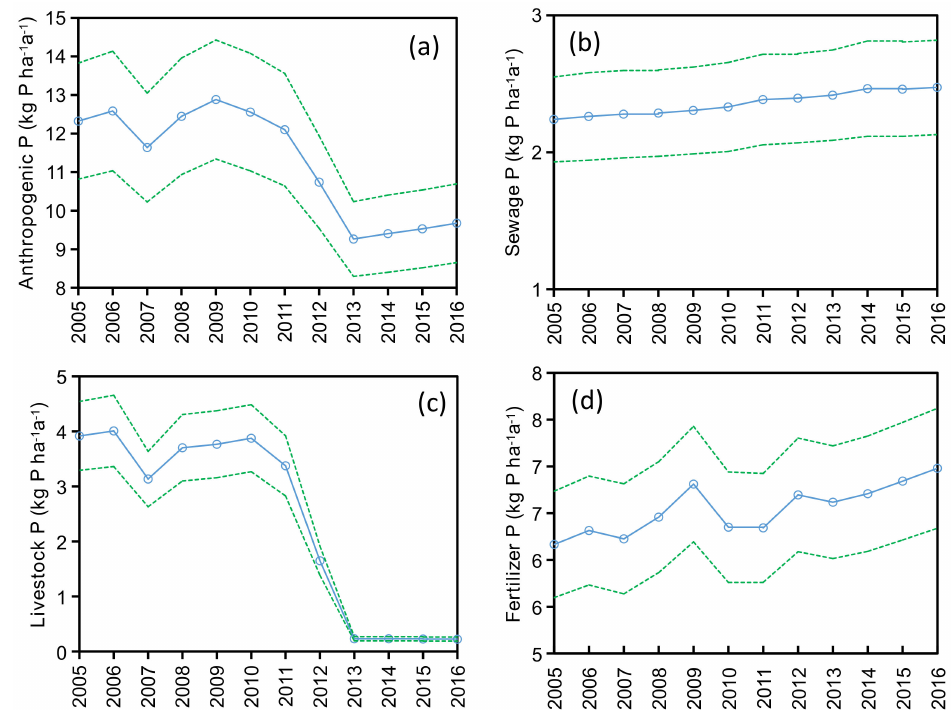
Figure 5. Annual ( a ) anthropogenic P, ( b ) sewage P, ( c ) livestock P, and ( d ) fertilizer P inputs within SDWSA (Shanxi Drinking-Water Source Area) during 2005–2016. Green shading denotes the 95% confidence interval obtained from Monte Carlo